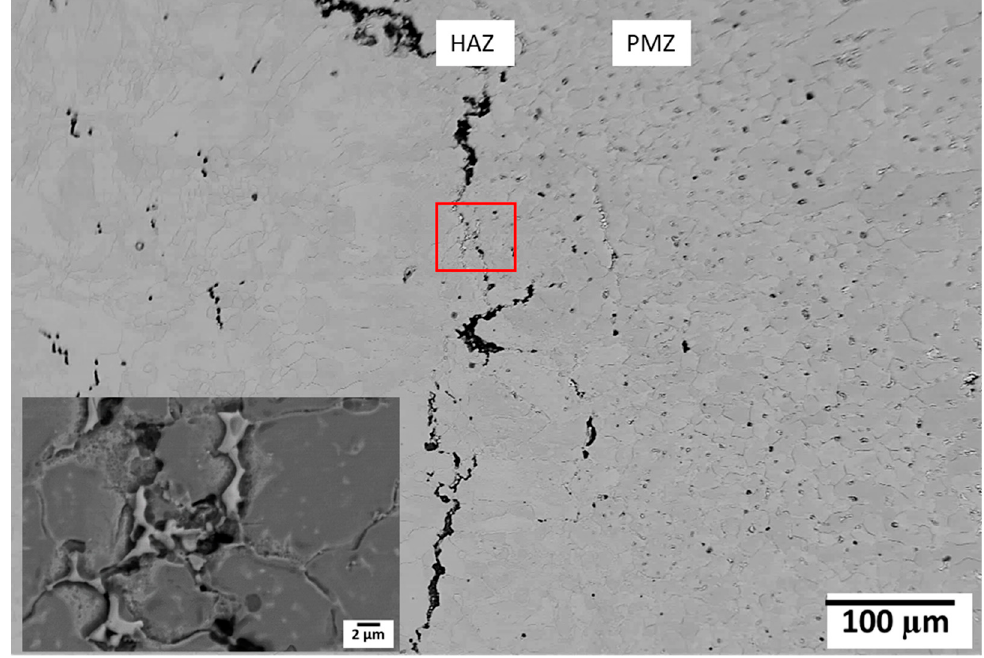
Figure 9. HAZ liquation cracking in SLM as-built condition; inset showing the marked area.